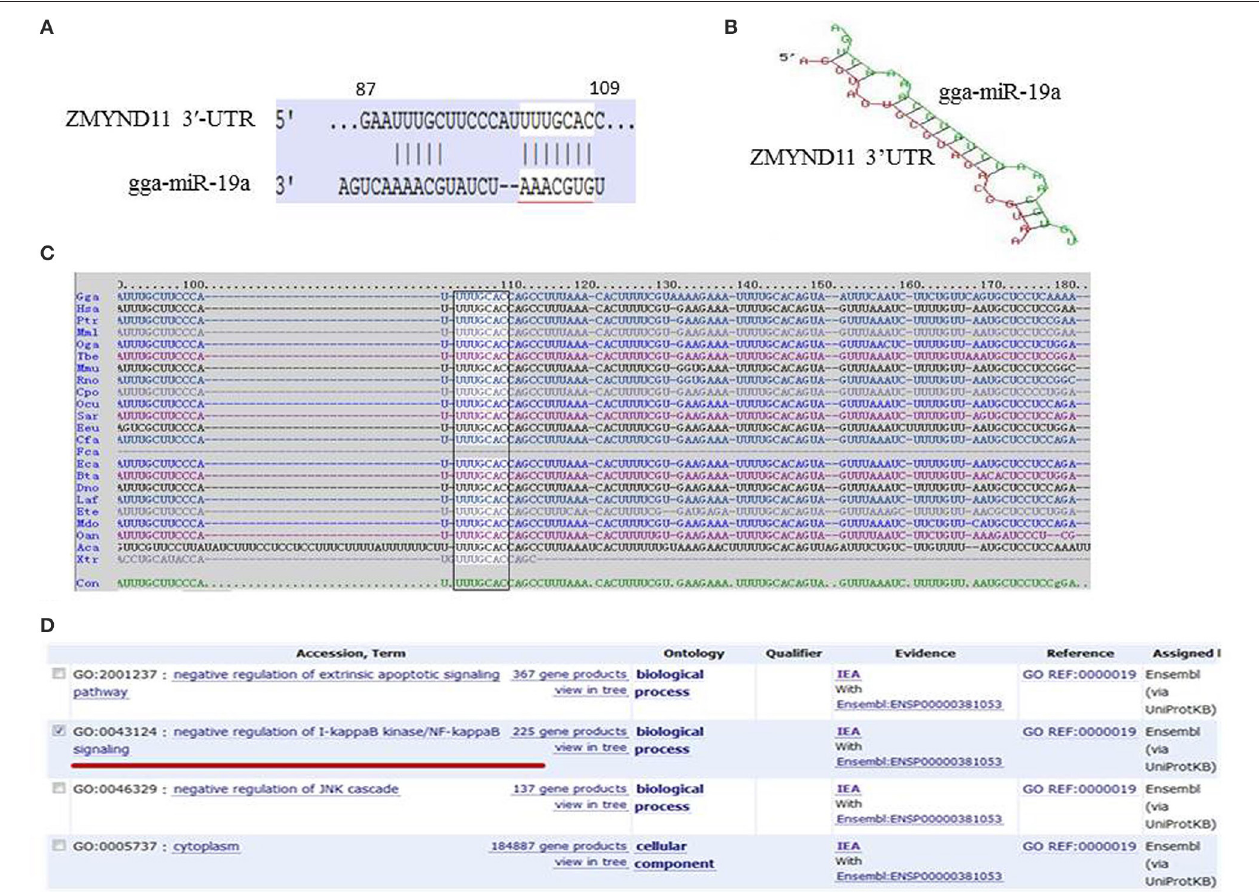
FIGURE 1 | Bioinformatics analysis of the target genes of gga-miR-19a. (A) Sequence schematic diagram of gga-miR-19a and the target site in the 3 ′ -UTR of ZMYND11 . The seed sequence of gga-miR-19a is underlined, and the matching or complementary nucleotides between gga-miR-19a and ZMYND11 3 ′ -UTR are indicated; (B) The predicted secondary structure of the RNA duplex of gga-miR-19a and the ZMYND11 3 ′ -UTR target site (Red: Target sequence; Green: gga-miR19a); (C) Sequence alignment of ZMYND11 3 ′ -UTR from different species. The conserved target sequences are highlighted; (D) Predicted function of the target gene of